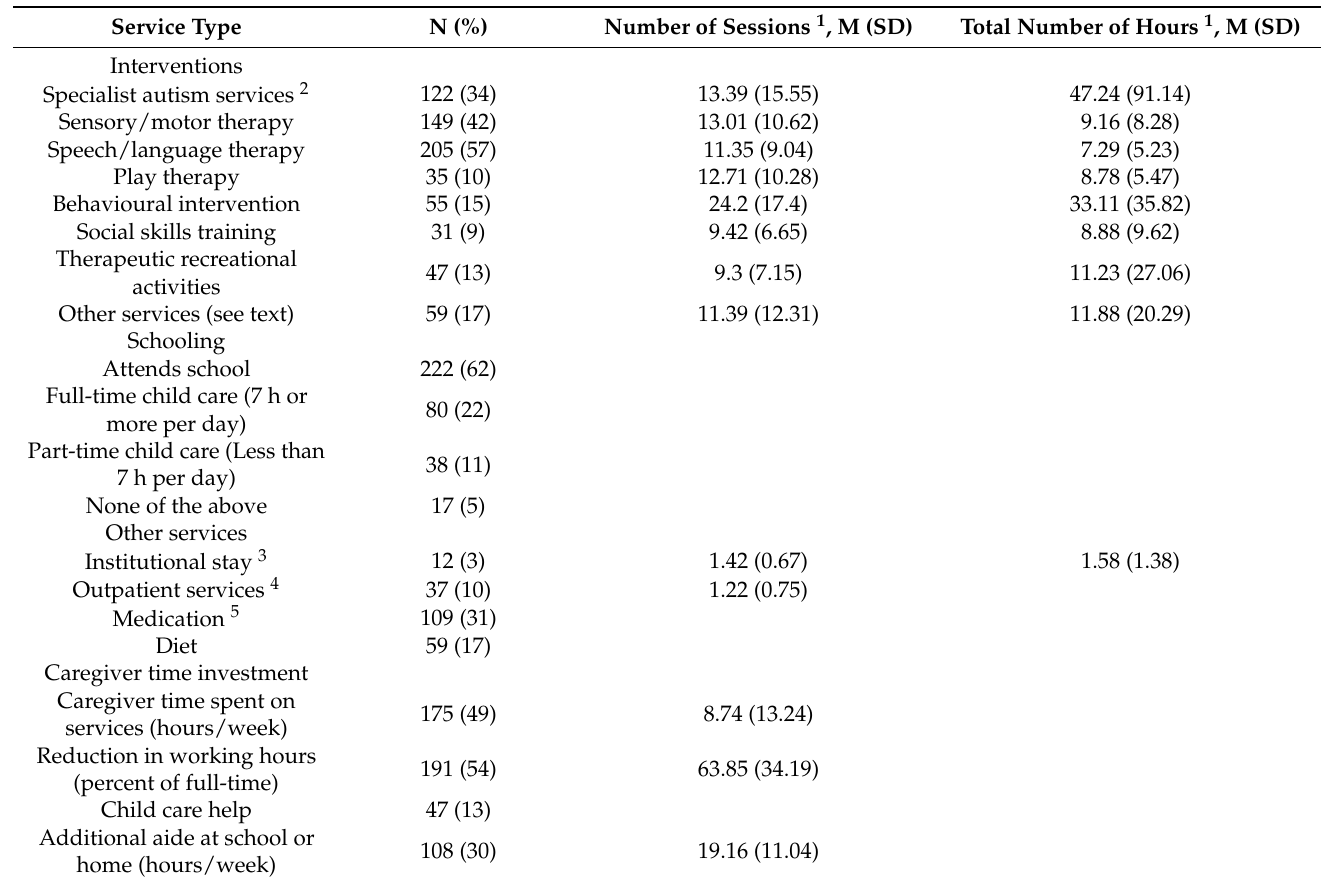
Table 2. Services received by 357 children with